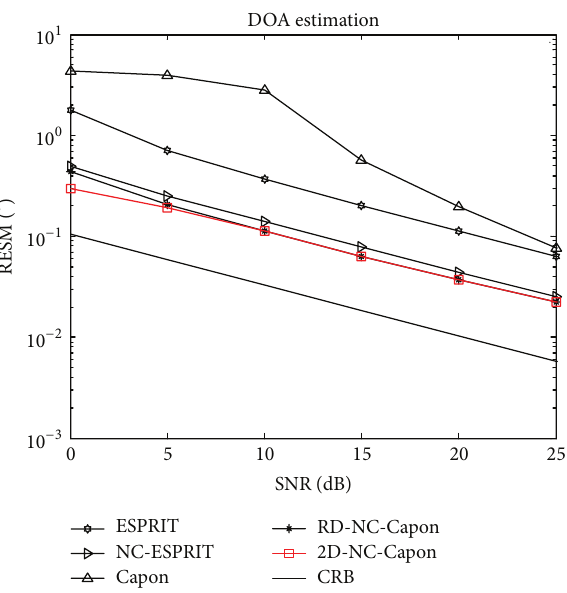
Figure 7: The DOA estimation performance comparison for uni- form linear array ( 𝑀 = 8 , 𝐿 = 200 , and 𝐾 = 3